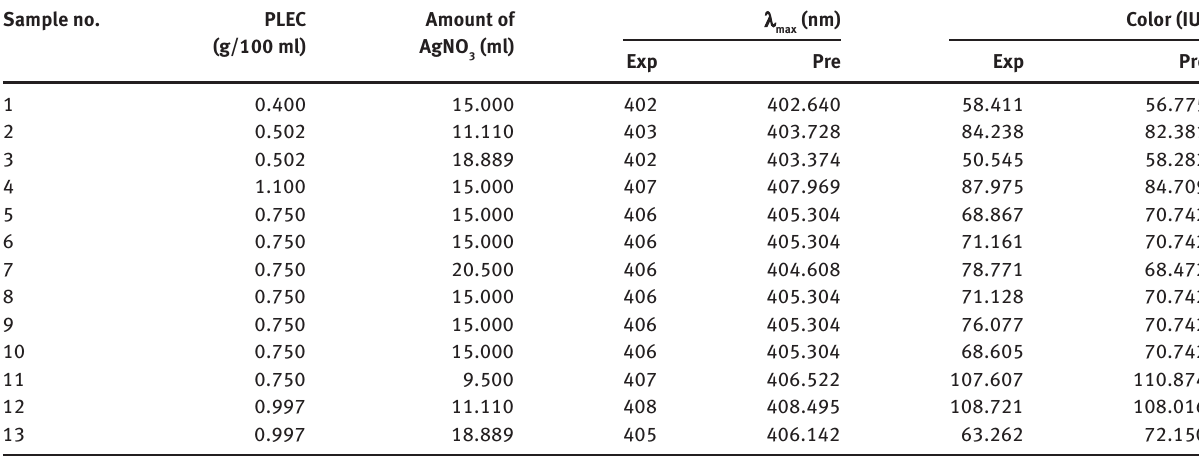
Table 2: CCD and response variables for AgNP synthesis. Sample no.